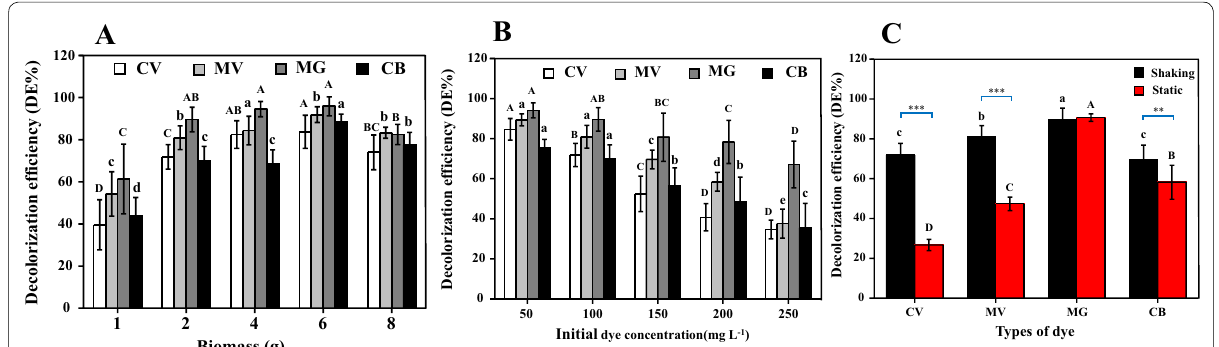
Fig. 2 Optimum decolorization conditions for isolate SWUSI4. A: Influence of biomass (1, 2, 4, 6 and 8 g, respectively) of SWUSI4 on the decolorization activities of CV, MV, MG and CB. B: Influence of initial dye concentrations (50, 100, 150, 200 and 250 mg L − 1 , respectively) of SWUSI4 on the decolorization activities of CV, MV, MG and CB. C: Influence of static and shaking conditions of SWUSI4 on the decolorization activities of CV, MV, MG and CB. Note: Means with the same letters and captions are not significantly different at honestly significant difference (HSD (0.05)). Mean comparisons are made for means with the same fonts. For example, means designated “A” compared to another mean with “A” Duncan grouping is not significantly different, while “A” compared to “B” and “C” is significantly different. Similarly, means with “a” are not significantly different compared to “a” but are for “b” and “c”. “**” indicates significant difference based on T -test (** p < 0.01, *** p < 0.001). Bars indicate standard deviation of